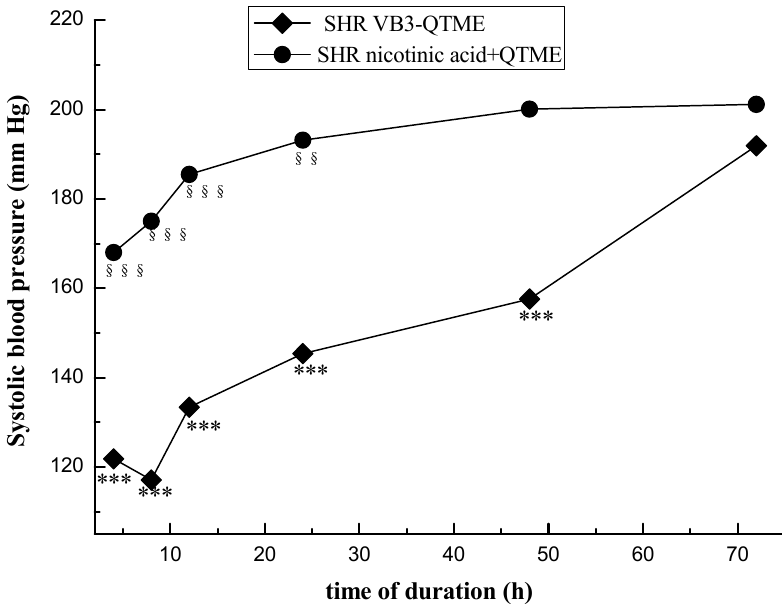
Figure 2. Duration time after the 7 days’ VB3-QTME and nicotinic acid+QTME treatment in SHR. Each point represents the mean SBP in six rats. The data were given as means ± SEM. *** p < 0.001, between before treatment and after the 7 days’ treatment VB3-QTME; §§ p < 0.01, §§§ p < 0.001, between before treatment and after the 7 days’ treatment nicotinic